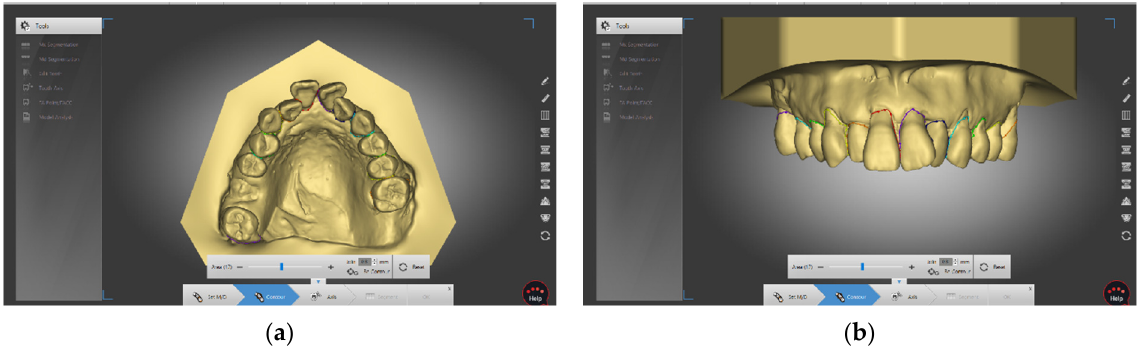
Figure 5. ( a ) In order to more accurately realize the crown of each tooth, the screen is curved by placing additional dots between the markings of each tooth performed in Figure 4b. The degree of curvature is also freely adjustable. The gingival margin and the boundaries between the teeth are precisely marked. ( b ) The screen of ( a ) viewed from the